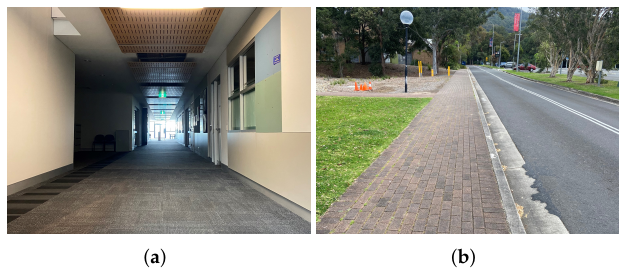
Figure 6. Experimental environments. ( a ) Indoors; ( b )